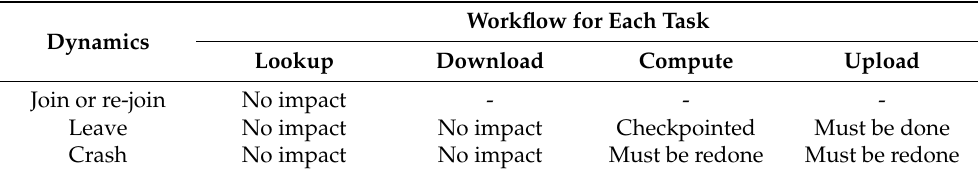
Table 1. The dynamics and its impact on MapReduce